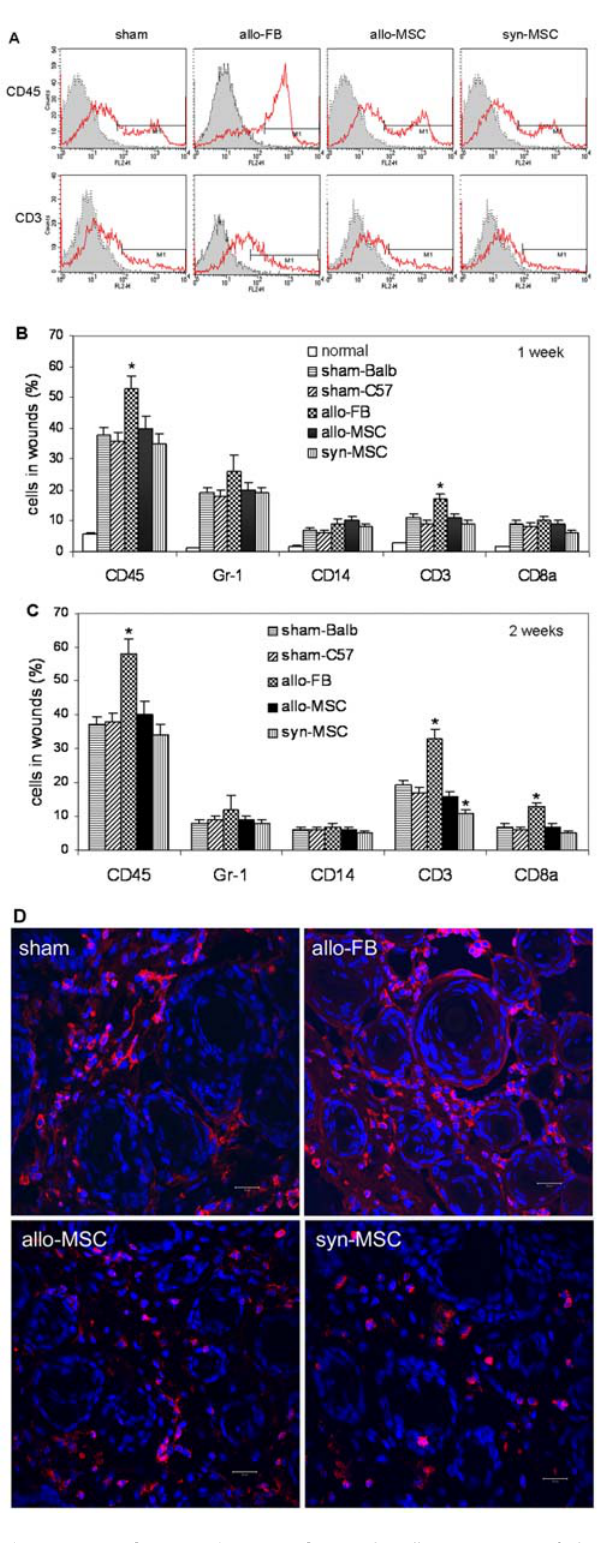
Figure 4. Leukocytes in wounds. Single-cell suspensions of the normal skin or wounds treated with allo-fibroblasts, allogeneic (allo-) or syngeneic (syn-) BM-MSCs or vehicle medium (sham) in Balb/C or C57BL/6 mice at 7 or 14 days were analyzed by flow cytometry after immunostaining. (A) Representative results of analysis of day 14 wound single cell suspensions for CD45 + leukocytes or CD3 + T cells (read peaks). Grey peaks represent negative controls. (B&C) Shown are